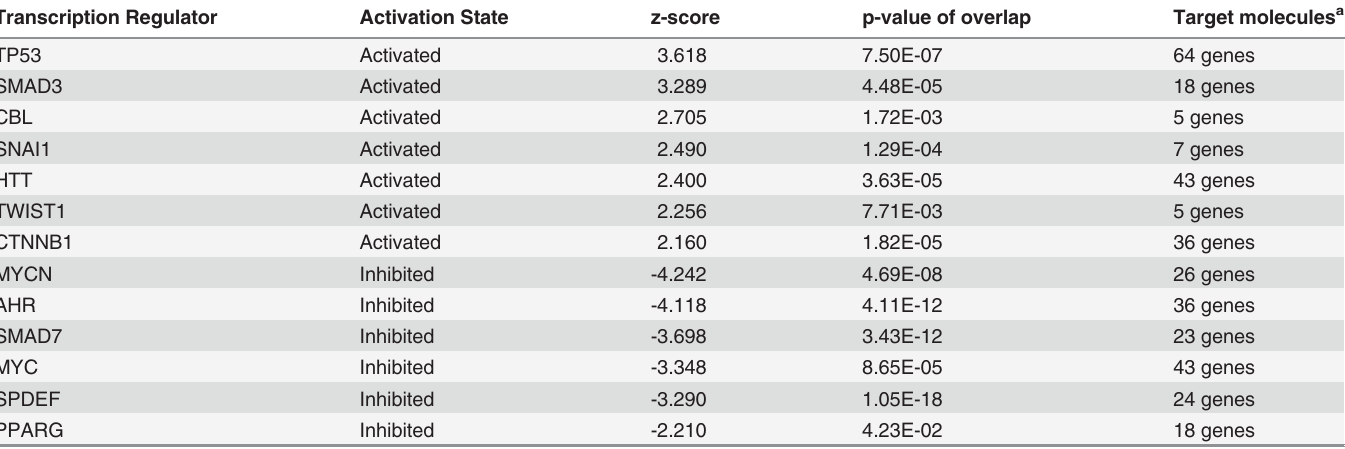
a All target molecules are listed in S3 Table.